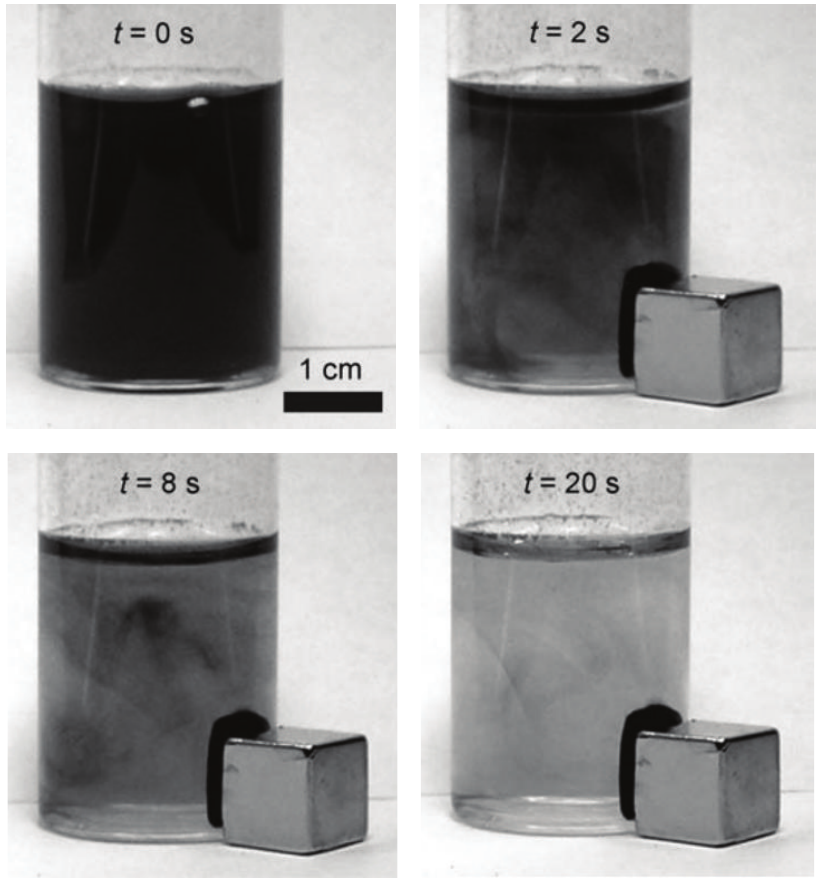
Figure 14: Magnetically separable nanocatalysts similar to those offered by TurboBeads [14] (used with permission from John Wiley and